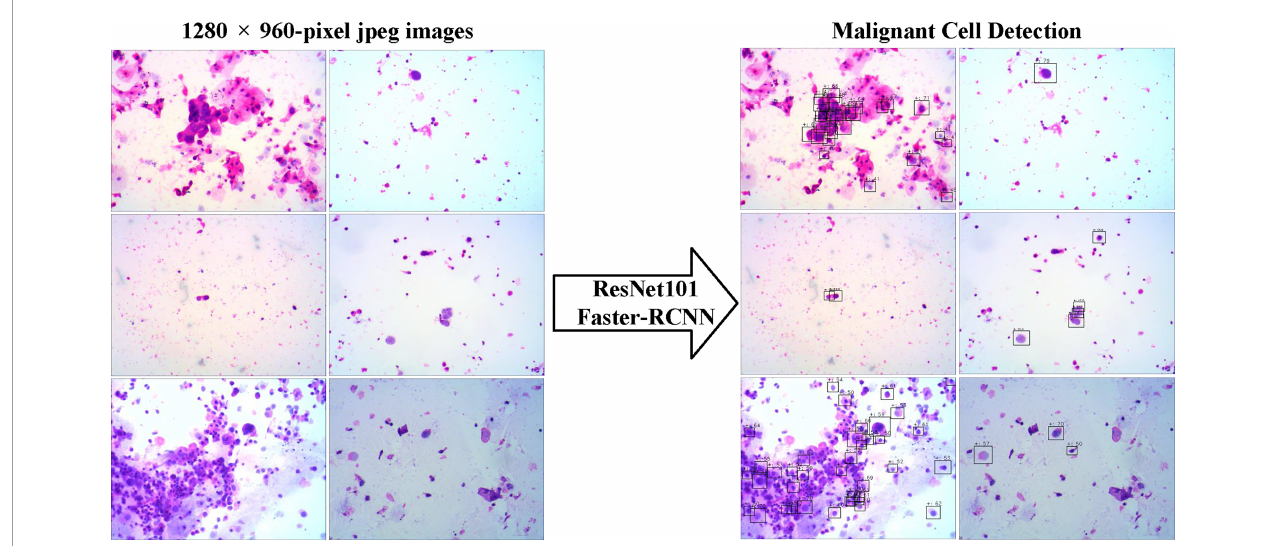
FIGURE 3 | The examples of snapshot images from positive cases and the results by the deep learning system were provided. The malignant cells detected were labeled by the Faster-RCNN, and the possibilities of each detection were also shown.